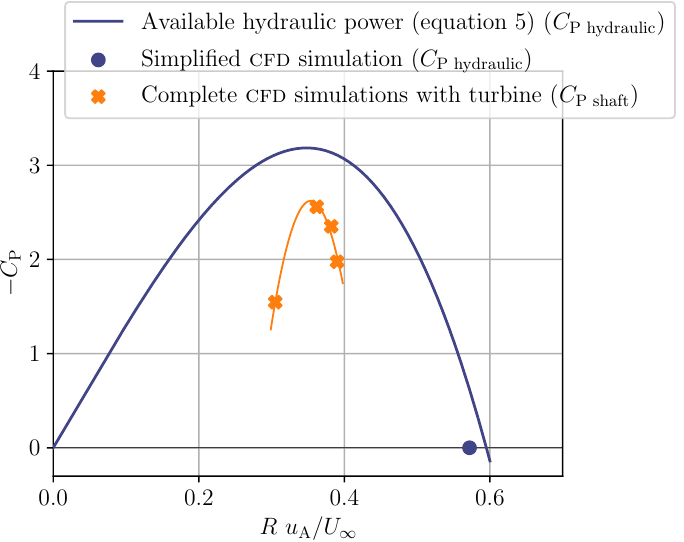
Figure 8. The turbine shaft power readings from Figure 7, this time non-dimensionalized as per the model developed in this chapter (orange crosses). In addition, a single simplified simulation has been run (rightmost circle data point), and the corresponding power curve has been